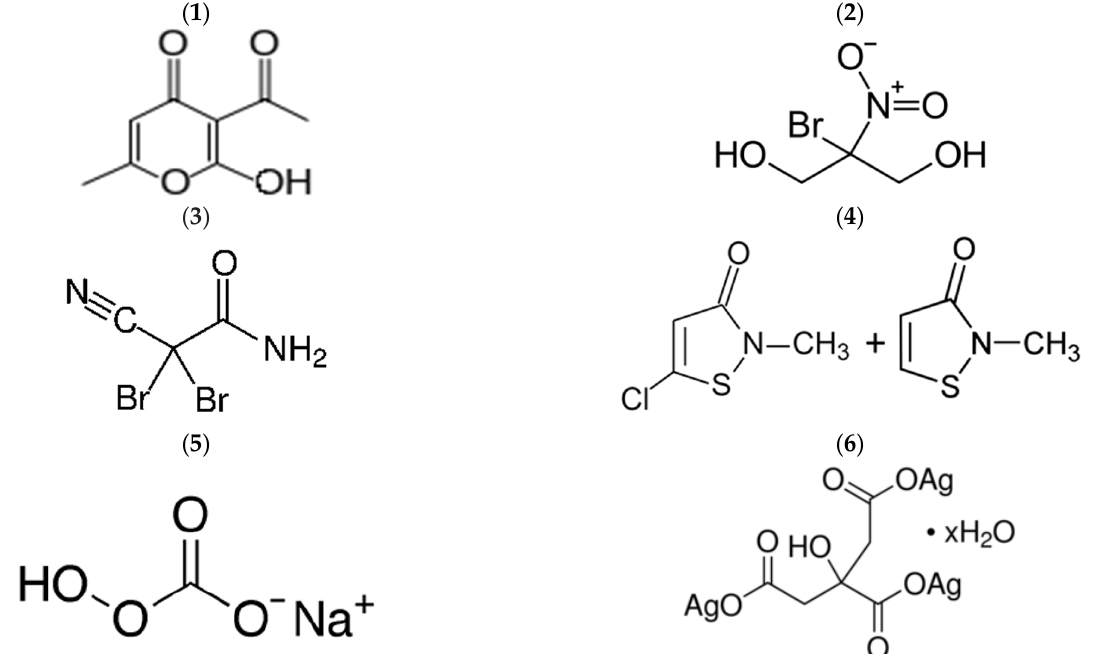
Figure 1. Structural formulas of some of the biocides used in this study. ( 1 ) Dehydroacetic acid (DA), ( 2 ) Bronopol (B), ( 3 ) 2,2-dibromo-3-nitrilopropionamide (DBNPA), ( 4 ) Sharomix (Methylchloroisoth- iazolnone + Methylisothiazolinone) (SH), ( 5 ) Sodium percarbonate (P), ( 6 ) Silver citrate